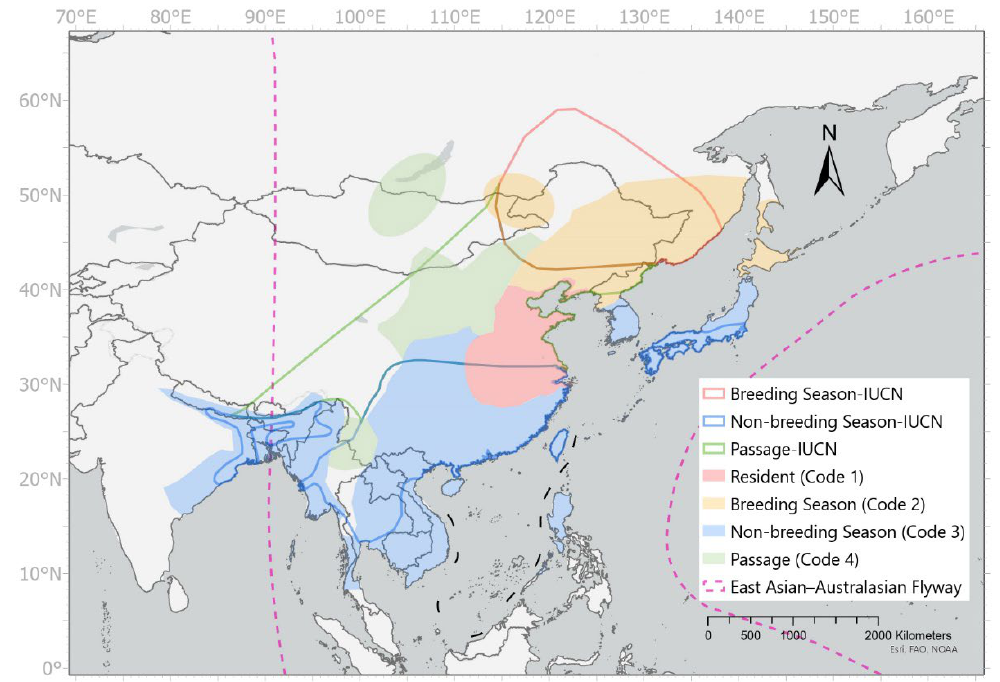
Figure 5. Updated Distribution Map of Baer’s Pochard based on the results of this study.